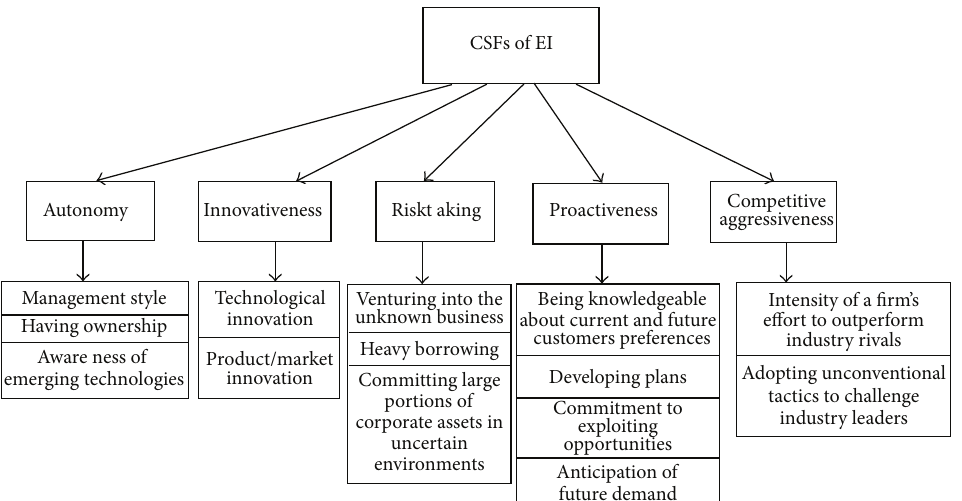
Figure 4: Hierarchy of the